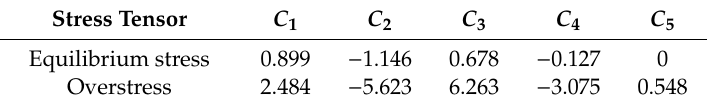
Table 1. Parameters of equilibrium stress and overstress (unit: